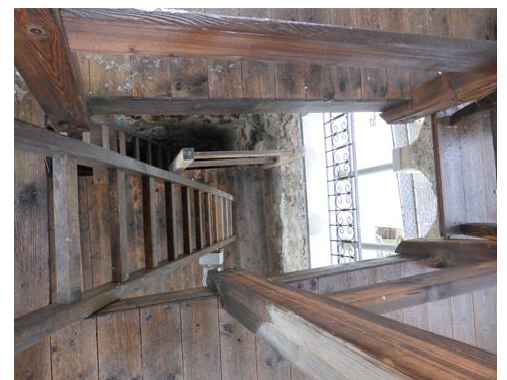
Figure 2. View of inside from A floor